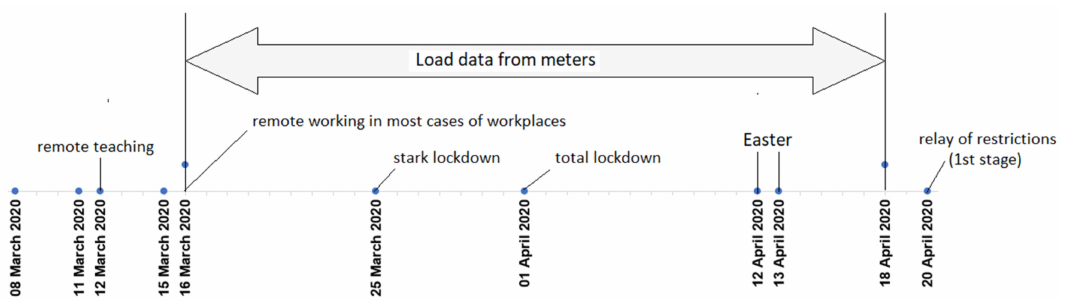
Figure 1. Timeline with the dates of introducing significant restrictions for Polish residents during the national quarantine (lockdown) period during the first wave of the COVID-19 pandemic in 2020 and the recording period of measurement data used in the